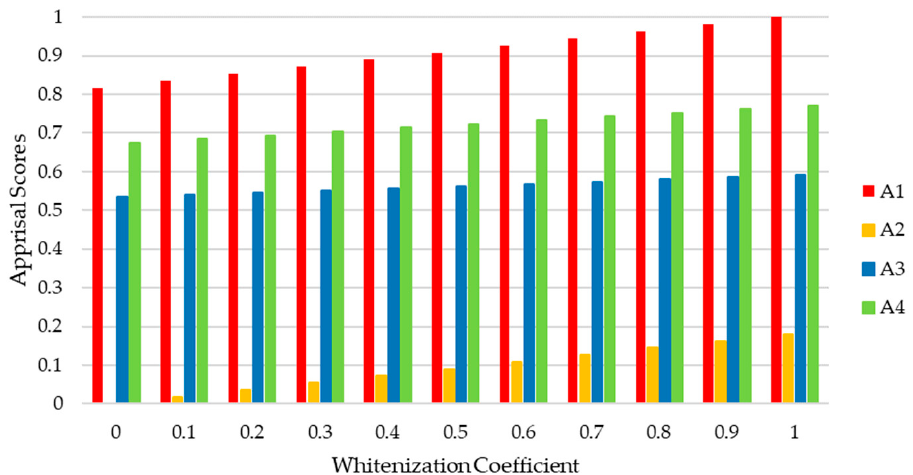
Figure 6. Whitenization coefficient sensitivity analysis for EDAS.